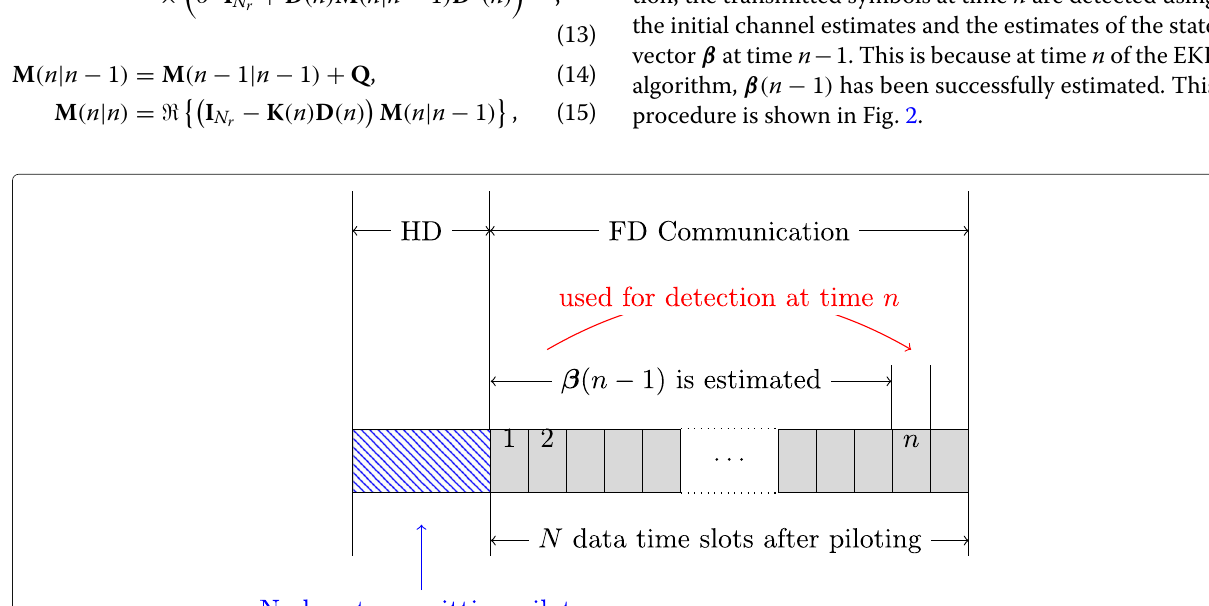
Fig. 2 Time diagram of modified